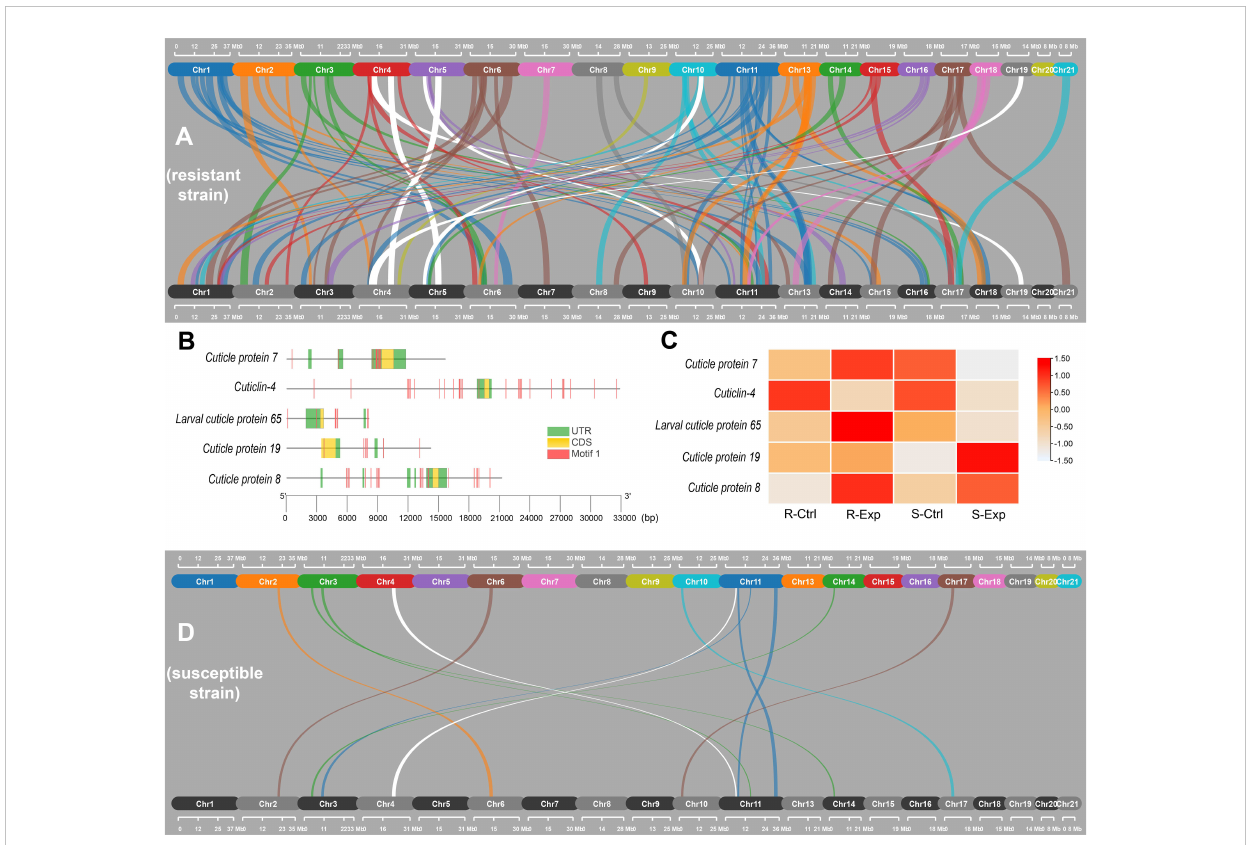
FIGURE 4 Analysis of gene duplications in cuticle protein genes in susceptible and resistant strains of C . rogercresseyi . (A, D) collinear duplicated genes in resistant (A) and susceptible (D) strains found in SynVisio software. White links corresponded to alignments involving cuticle protein genes. (B) Gene structure of cuticle protein genes duplicated in the resistant or the susceptible populations. Motif 1 was obtained through the MEME suite with default parameters. (C) gene expression of cuticle protein genes (normalized TPM values) for control samples (Ctrl) and samples exposed to azamethiphos (Exp) in both